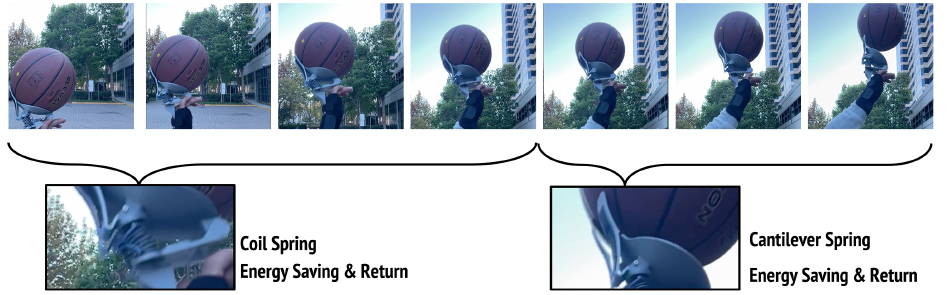
Figure 14. The sequence of shooting with two energy storage and return devices—coil and cantilever springs—in the proposed